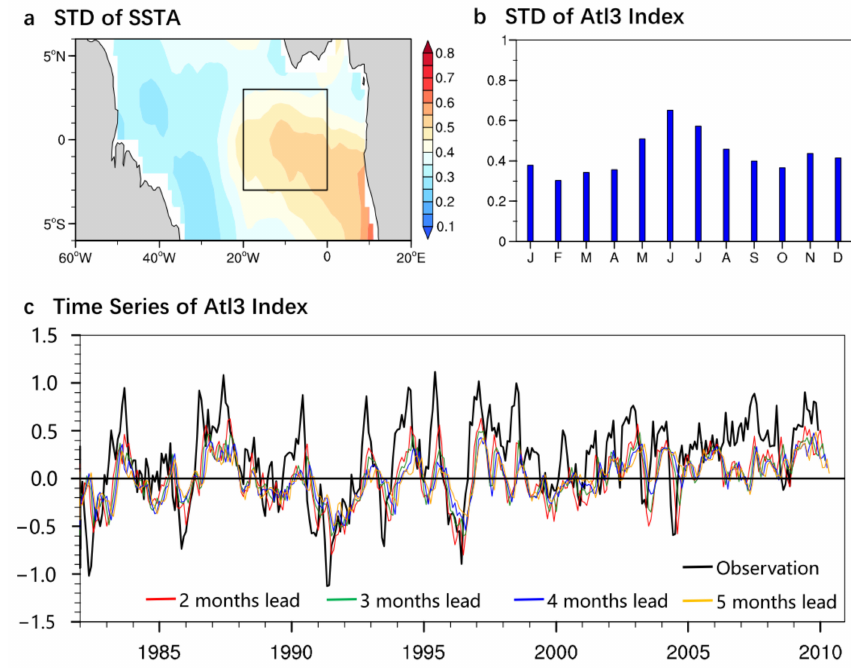
Figure 1. ( a ) Standard deviation (STD) of observed SST anomalies in the tropical Atlantic. The black box denotes the Atl3 region (3 ◦ S–3 ◦ N, 20 ◦ W–0 ◦ E), and the SST anomalies averaged over the Atl3 region denote the Atl3 index. ( b ) STD of Atl3 index as a function of calendar month. ( c ) Time series of the Atl3 index for two-month-lead (red curve), three-month-lead (green curve), four-month-lead (blue curve), five-month-lead (orange curve) forecasts and the observation (black